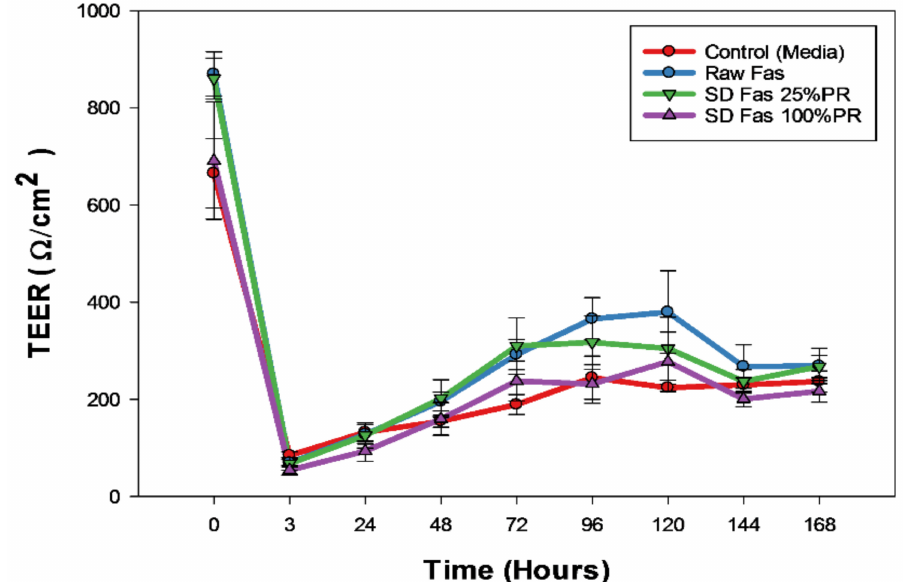
Figure 11. In vitro transepithelial electrical resistance (TEER) analysis of Calu-3 human lung epithelial cells from the large airways exposed to representative aerosolized formulations under air-interface culture (AIC)